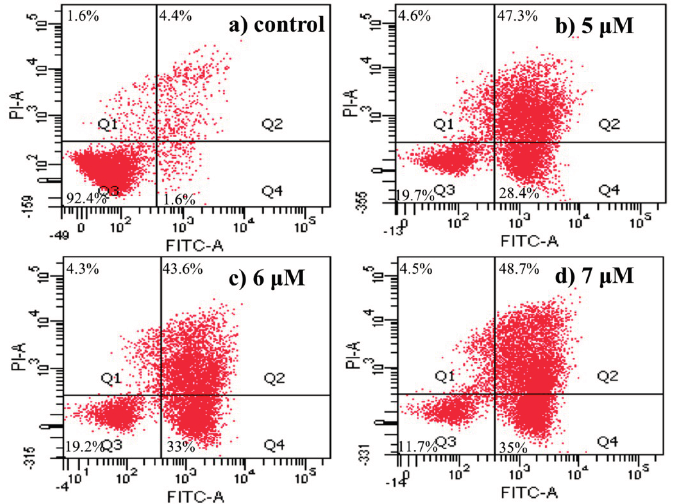
Figure 5. Apoptosis analysis by FCM using AnnexinV-FITC/PI staining: ( a ) control group; ( b ) 5 μ M; ( c ) 6 μ M; and ( d ) 7 μ